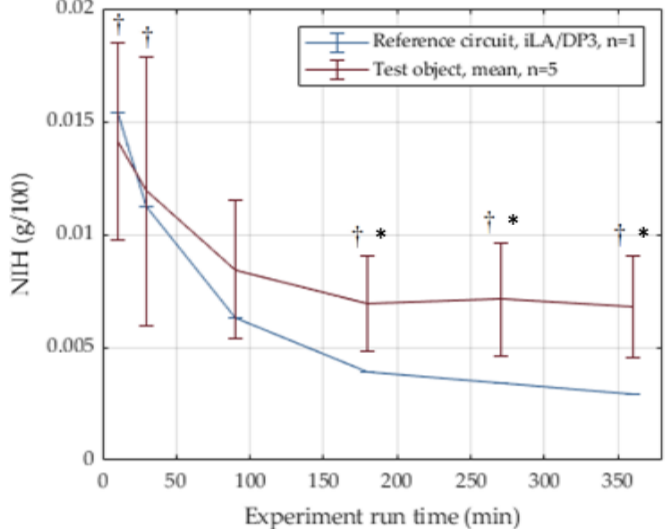
Figure 9. In vitro hemolysis results depicted as normalized index of hemolysis (NIH), mean and SD. The predicate device is depicted in blue (n = 1, iLA oxygenator, DP3 pump), and the test devices are depicted in red (n = 5). †: Normal distribution (tested with Kolmogorov–Smirnov), * : significant difference between test device and predicate (two-tailed one sample t -test, p < 0.05 for Gaussian distributions). The non-Gaussian distribution at t = 90 min was not further analyzed due to small sample size.